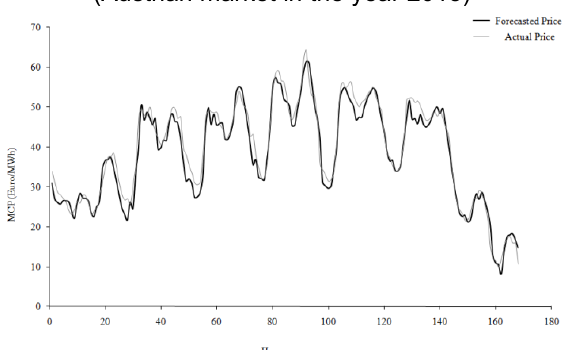
Figure 11 . Forecasted MCP for a spring week (Austrian market in the year 2015)